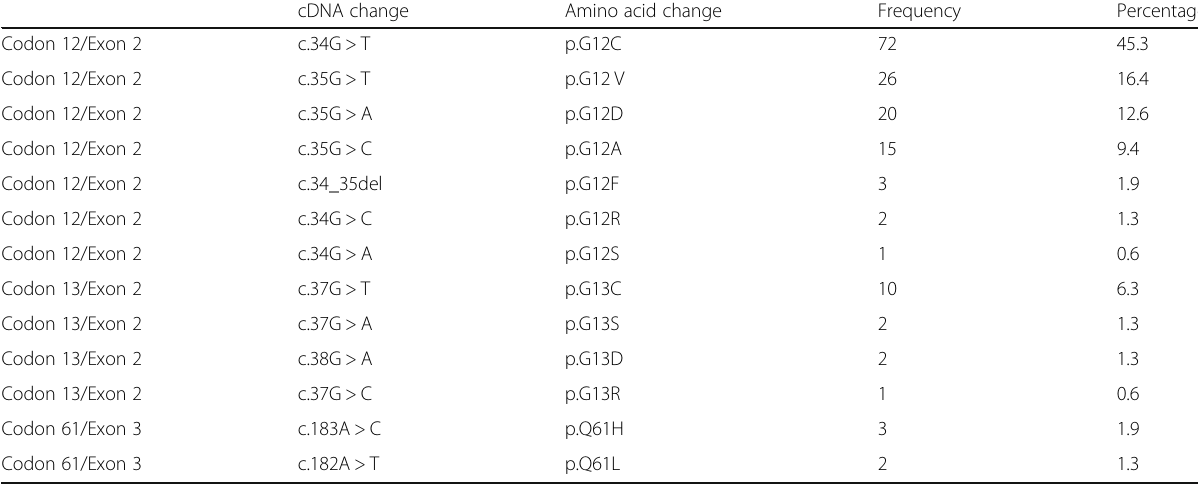
Table 5 KRAS mutations in 159 lung